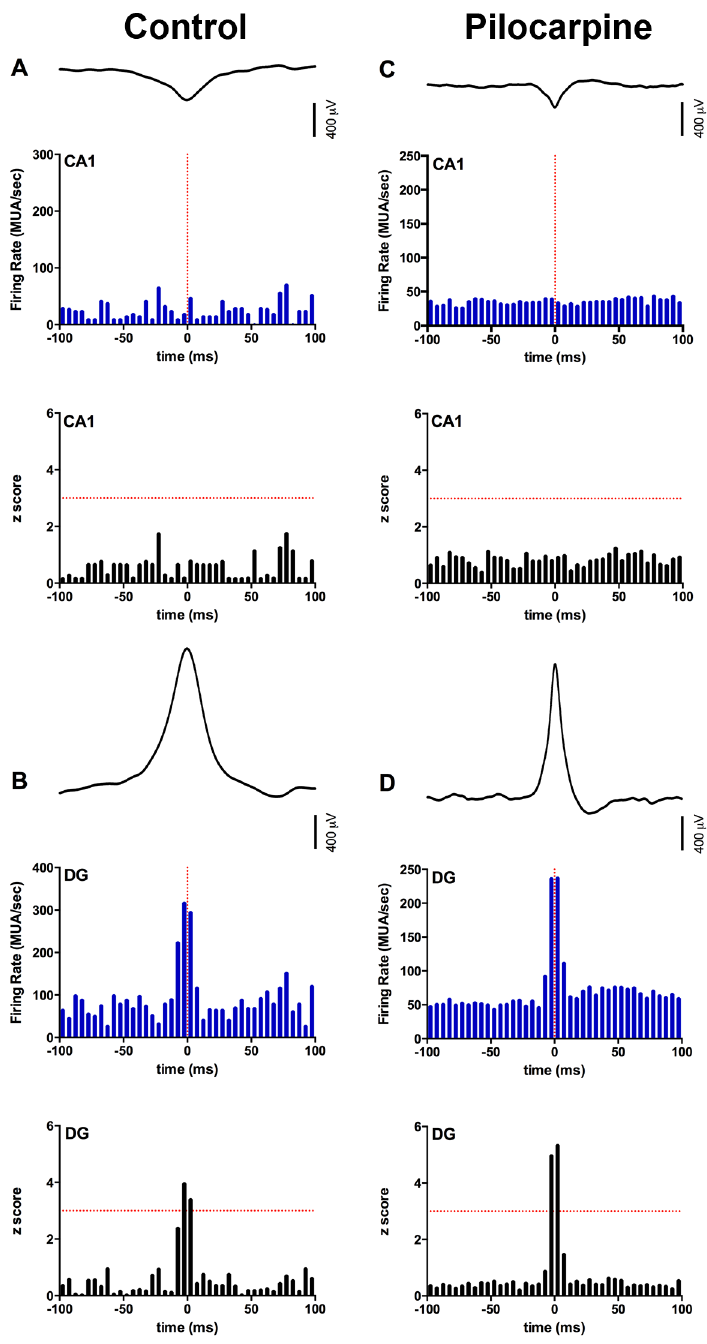
Fig 4. Perievent Time Histogram and z-scores of multiunit activity in the hippocampus during DS. MUA activity and z score of A) CA1 pyramidal cell layer and B) dentate granule cell layer in control animals. MUA activity and z score of C) CA1 pyramidal cell layer and D) dentate granule cell layer in pilocarpine- treated animals. The peak amplitude of DS was locked to time zero, depicted by the vertical dashed red line, in all perievent time histograms. Horizontal dashed red lines in z score plots indicate a z score of 3. No significant increase in MUA was seen in the CA1 pyramidal cell layer in either control or pilocarpine-treated animals. However, in both groups a significant increase in MUA, demonstrated by z-scores (cid:1) 3, was observed 5ms before and after DS.